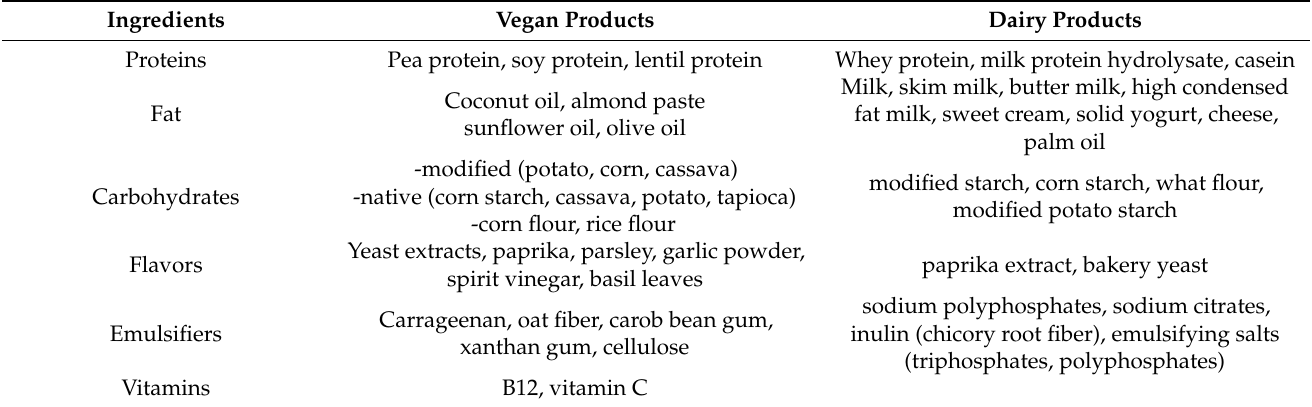
Table 3. Main ingredients of processed